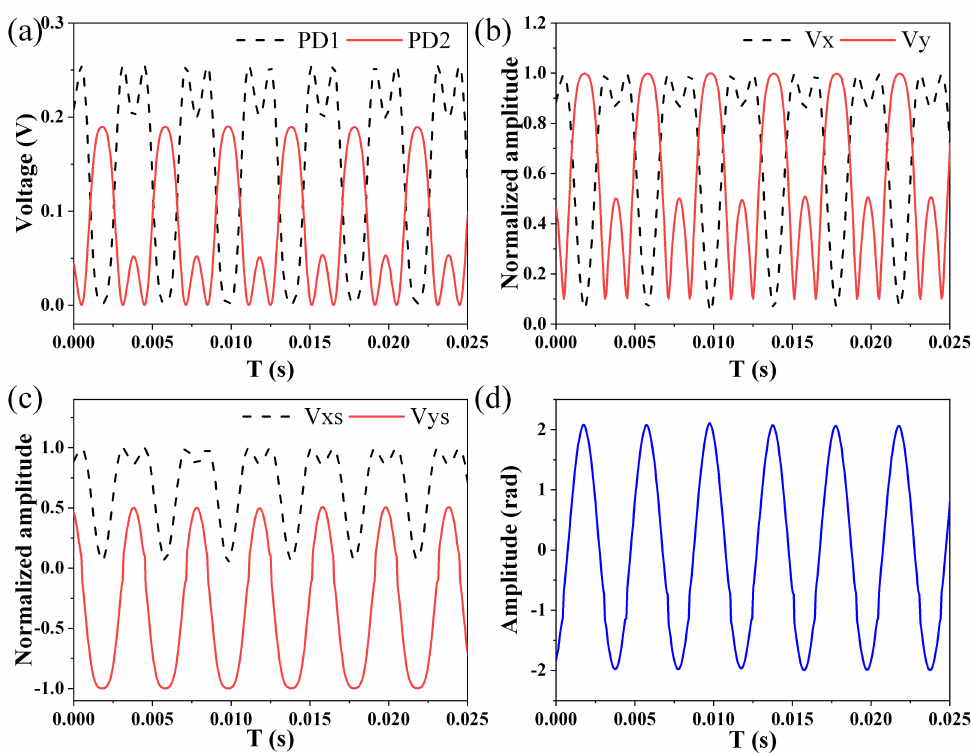
Figure 4. Experimental results in large signal condition. ( a ) Output signals from two photodetectors. ( b ) Orthogonal signals before removing absolute value sign. ( c ) Orthogonal signals after removing absolute value sign. ( d ) Demodulation phase